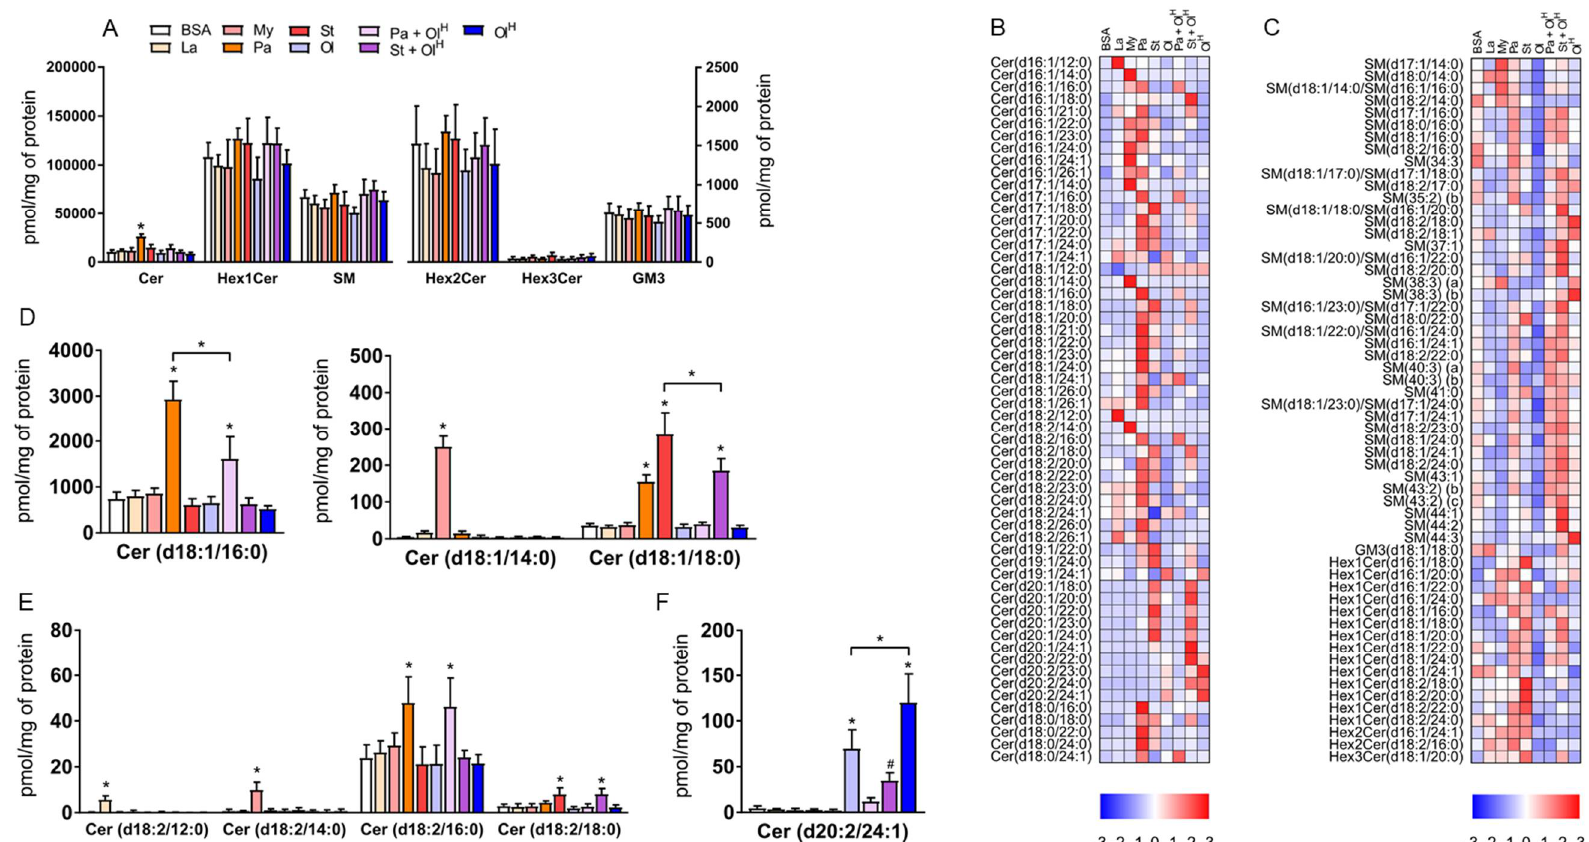
Figure 3. The effects of fatty acids on sphingolipids. ( A ) Concentrations of total ceramide (Cer), ceramide with 1, (Hex1Cer), 2 (Hex2Cer), or 3 (Hex3Cer) sugar moieties, GM3 Ganglioside (GM3) and sphingomyelin (SM) in BMDM treated with the indicated fatty acids. ( B , C ) Heat maps showing the indicated lipid species within Cer ( B ) and Hex1Cer, Hex2Cer, Hex3Cer and sphingomyelin ( C ) following treatment with fatty acids. Data are presented as Z-score by row. ( D – F ) Bar charts of the concentrations of specific lipid species. Data in A and D–F are the mean + SD. Symbols represent statistical significance compared with BSA or, where specifically indicated, between two particular groups at the following α levels: * p ≤ 0.001; # p ≤ 0.05. Data are from 6 independent mice.